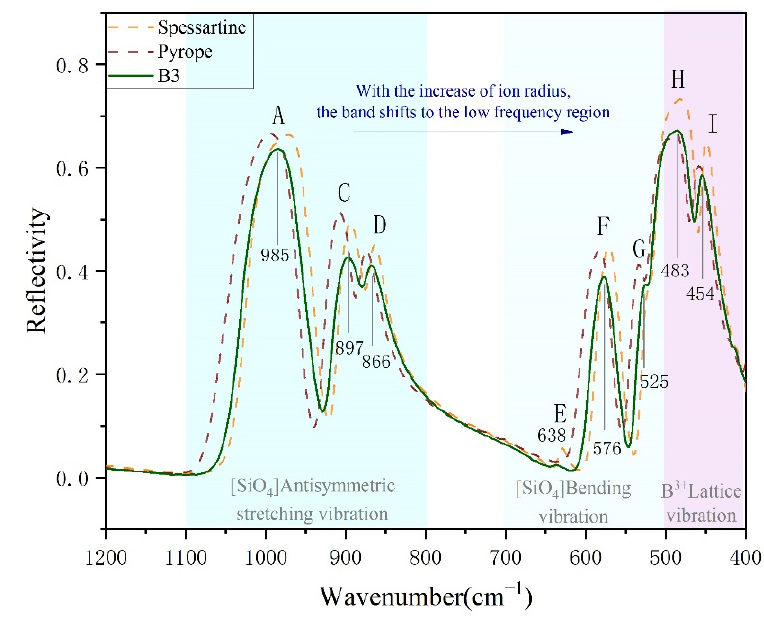
Figure 2. FTIR spectra of the colour-changing garnet (the spectral line data of pyrope and spessartine in the figure derived from subspecies of garnets identified by EPMA).